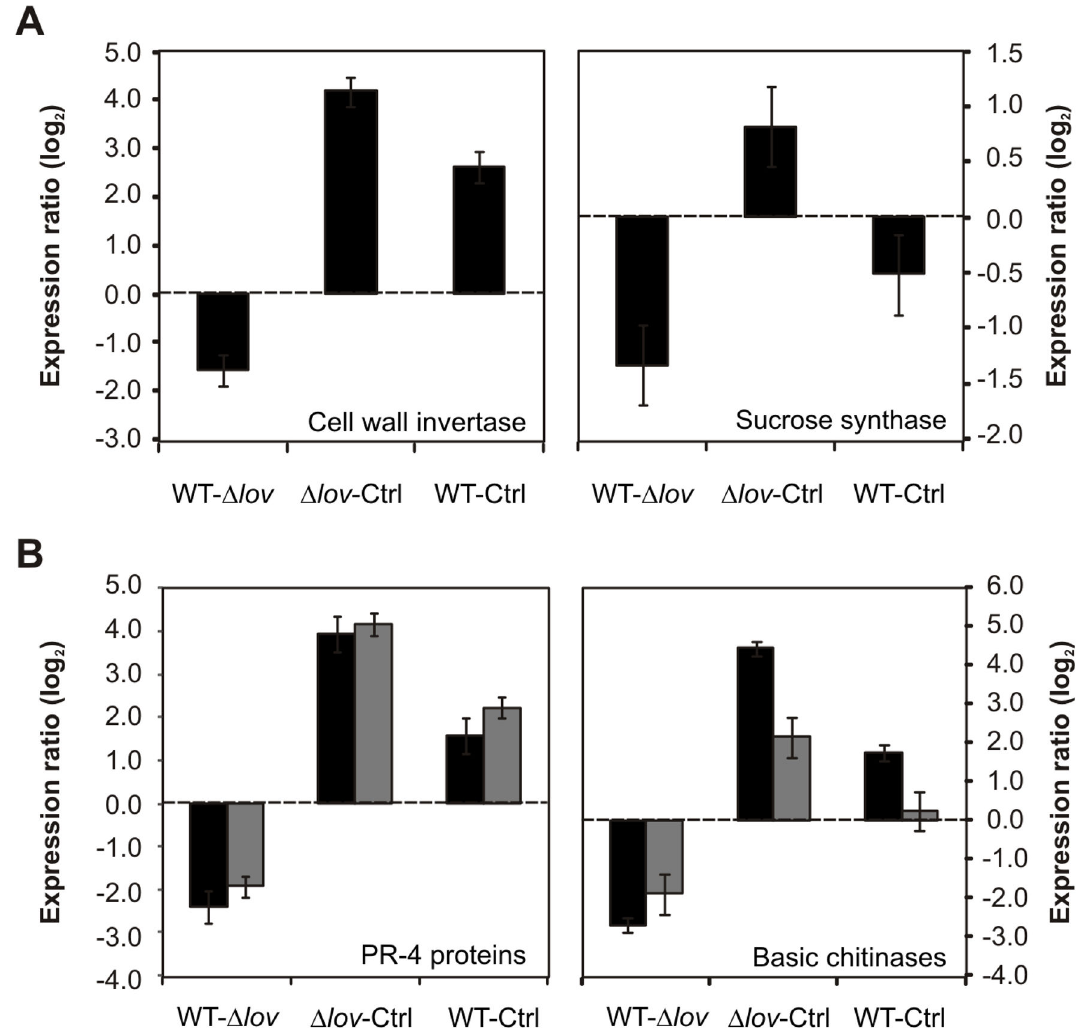
Figure 3. CHO metabolism- and defense response-related Citrus ESTs differentially regulated during Xanthomonas citri subsp. citri interaction. Expression ratios were calculated for genes differentially expressed in orange leaves inoculated with the WT and Δ lov X. citri subsp. citri strains and control treatments (10 mM MgCl , Ctrl) ( A ) Log of expression ratio between treatments 2 2 (M) for ESTs corresponding to a cell wall invertase and a sucrose synthase (orange1.1g008242m and orange1.1g008531m of Citrus sinensis ) ( B ) Log of expression ratio between treatments (M) for ESTs corresponding to two pathogenesis-related proteins 2 [orange1.1g032389m (black columns) and orange1.1g032285m (grey columns) of C. sinensis ] and two chitinases [orange1.1g020187m (black columns) and orange1.1g026315m (grey columns) of C. sinensis ]. Data are averages of values obtained from three independent biological samples. Bars represent standard error. Accession numbers correspond to the complete C. sinensis genes taken from the phytozome database (http://www.phytozome.net/citrus.php).